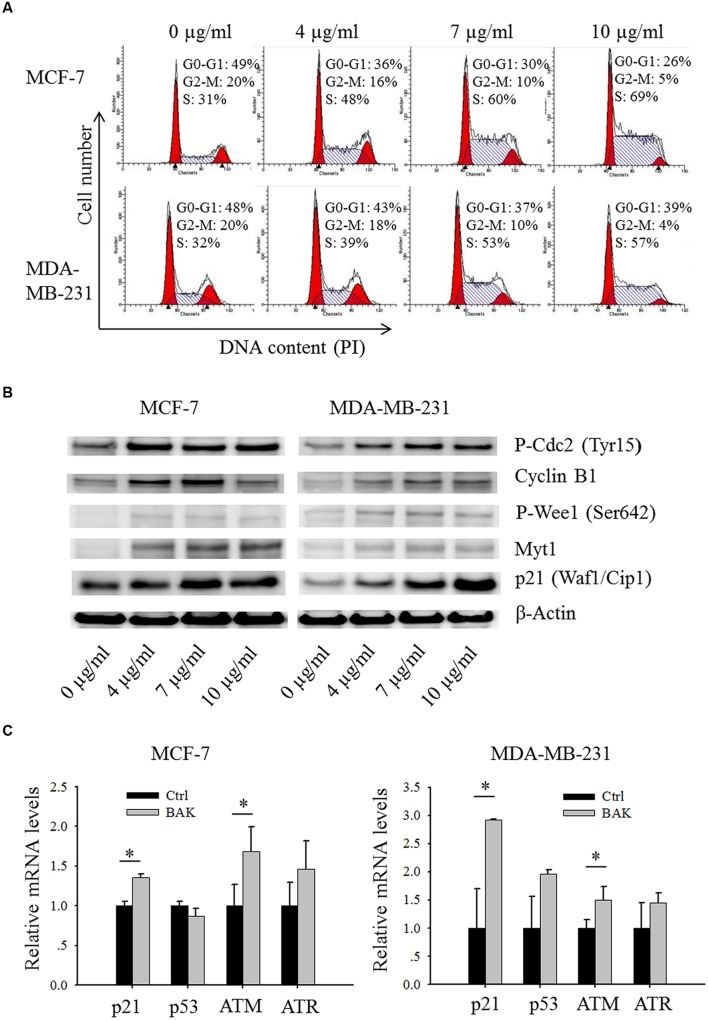
Bakuchiol induced alteration in cell cycle and cell cycle regulator expression in breast cancer cells. (A,B) Cells were treated with varying concentrations of bakuchiol as labeled in the figure for 24 h. (A) Cell cycle analysis with PI staining. (B) Expression levels of P-Cdc2 (Tyr15), Cyclin B1, P-Wee1 (Ser 642), Myt1, p21 (Waf1/Cip1) and β-Actin analyzed with Western blot (C) p21, p53, ATM and ATR mRNA expressions in cells treated with ethanol or 7 μg/ml of bakuchiol for 24 h. The data represent the mean ± SD of the values from three separate RNA samples (∗p < 0.05, student’s t-test). Ctrl, control; BAK, bakuchol.